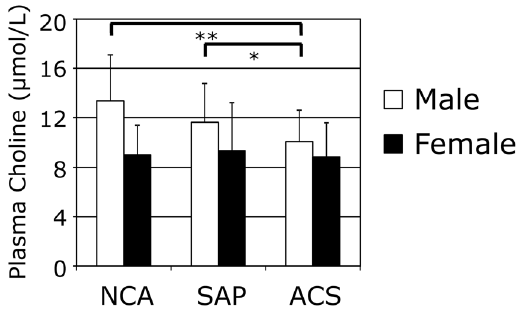
Figure 6. Association between plasma choline level and ACS. The concentrations of plasma choline in patients with NCA, SAP, or ACS are shown. The open bars represent the plasma choline levels in male subjects and the closed bars represent the levels in female subjects. Data are the mean ± SD; * P < 0.05, ** P <